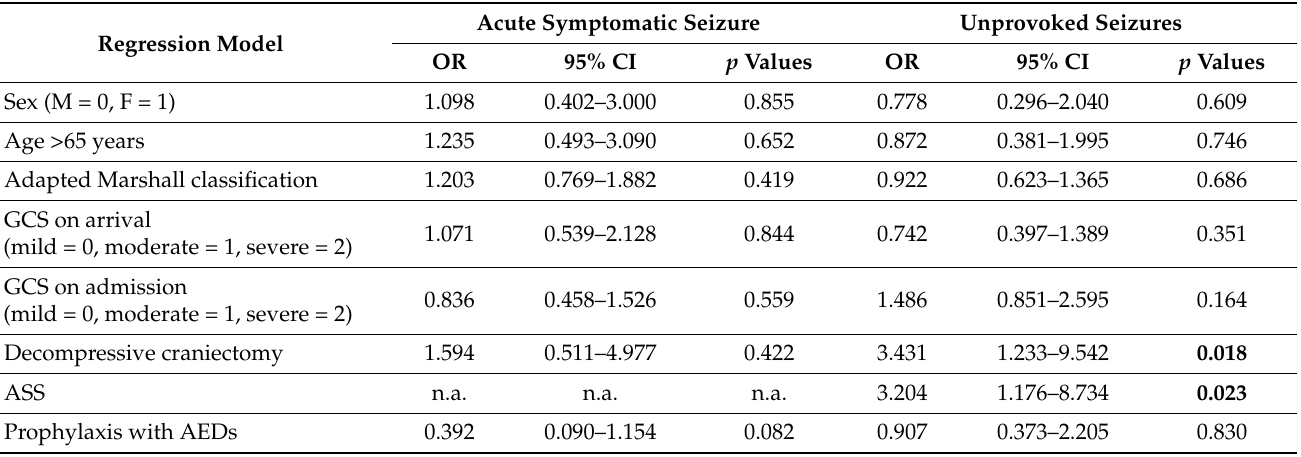
Table 4. Multivariable logistic regression analysis showing the potential risk factors for seizure occurrence in patients with